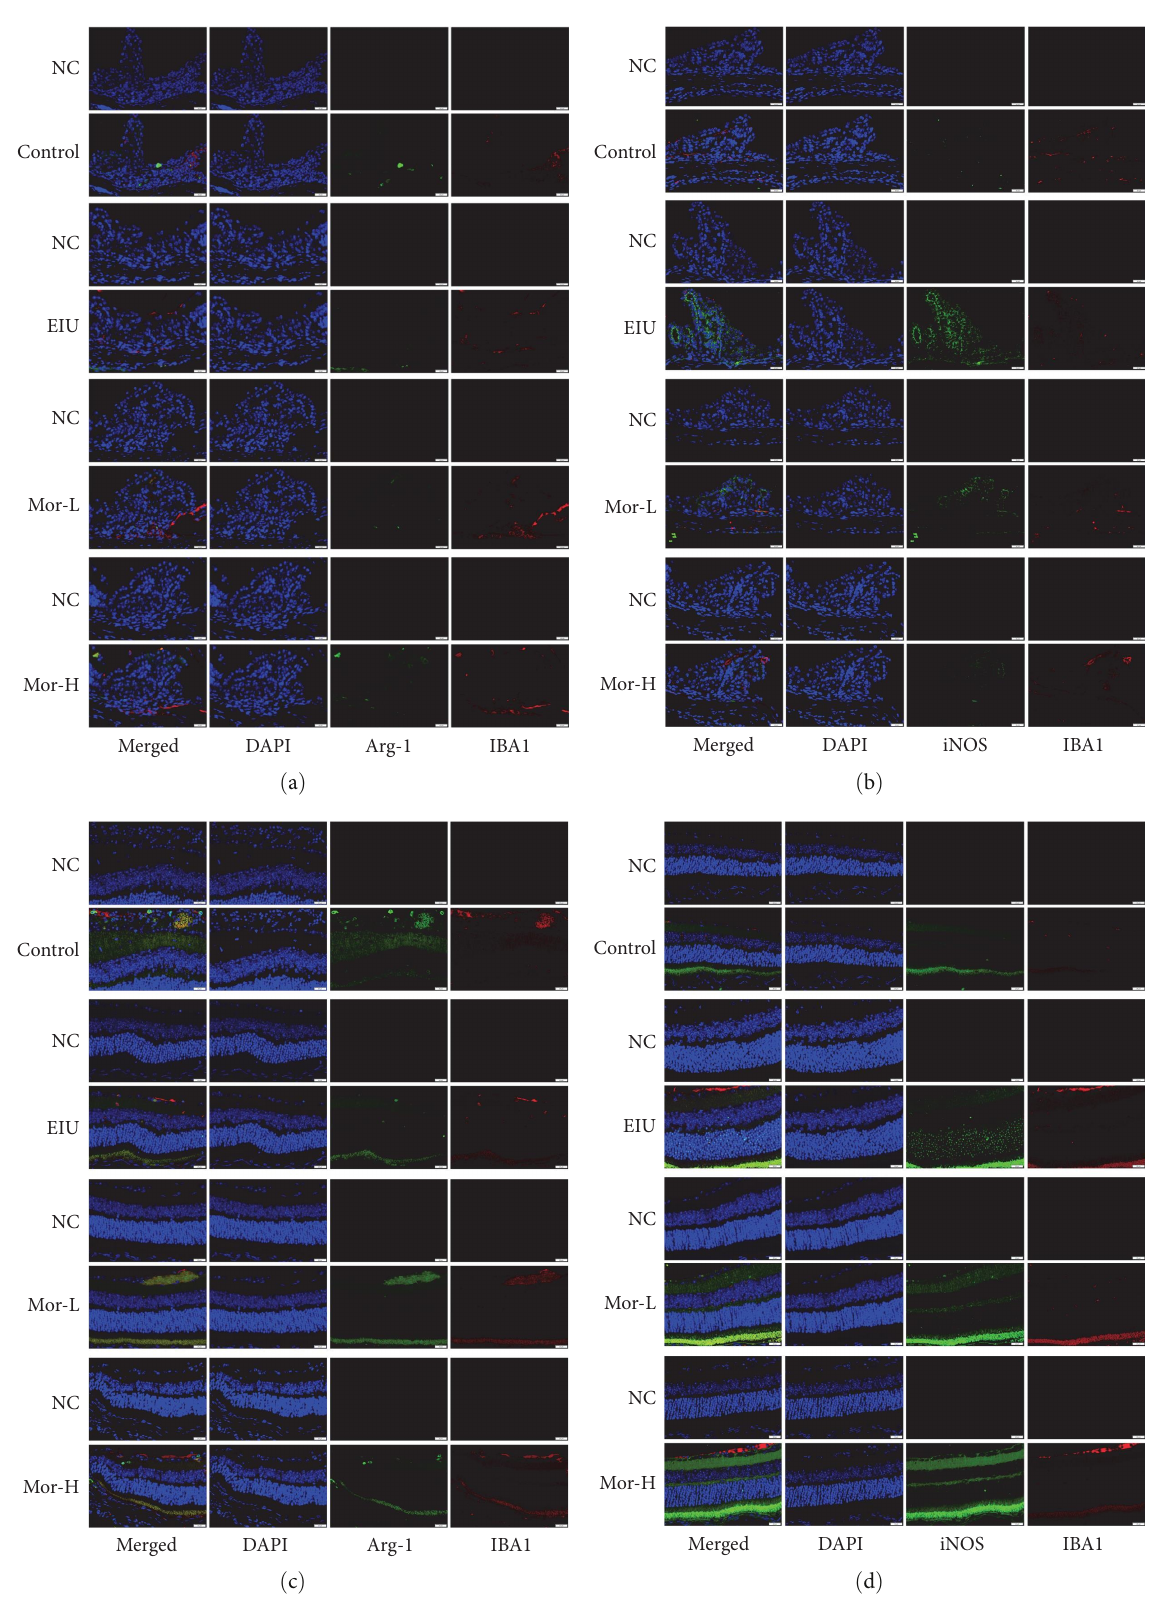
F IGURE 3: Effect of morroniside on M1/M2 polarization in iris ciliary body macrophages in EIU mice. (a) Arg-1 expression in the ciliary body tissues of mice (40 × , scale bar, 20 μ m). (b) iNOS expression in the ciliary body tissues of mice (40 × , scale bar, 20 μ m). (c) Expression of Arg-1 in the retinal tissues of mice (40 × , scale bar, 20 μ m). (d) Expression of iNOS in the retinal tissues of mice (40 × , scale bar, 20 μ